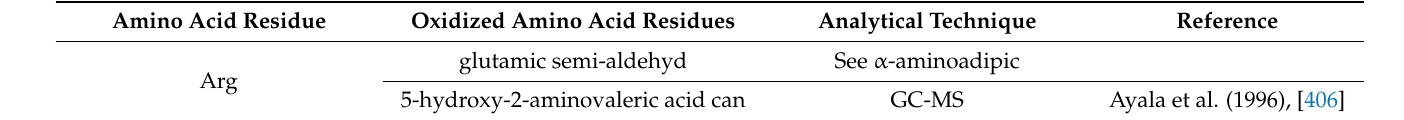
Table 12. Analytical techniques/assays to detect Arg oxidation products with the corresponding analytical techniques and relevant